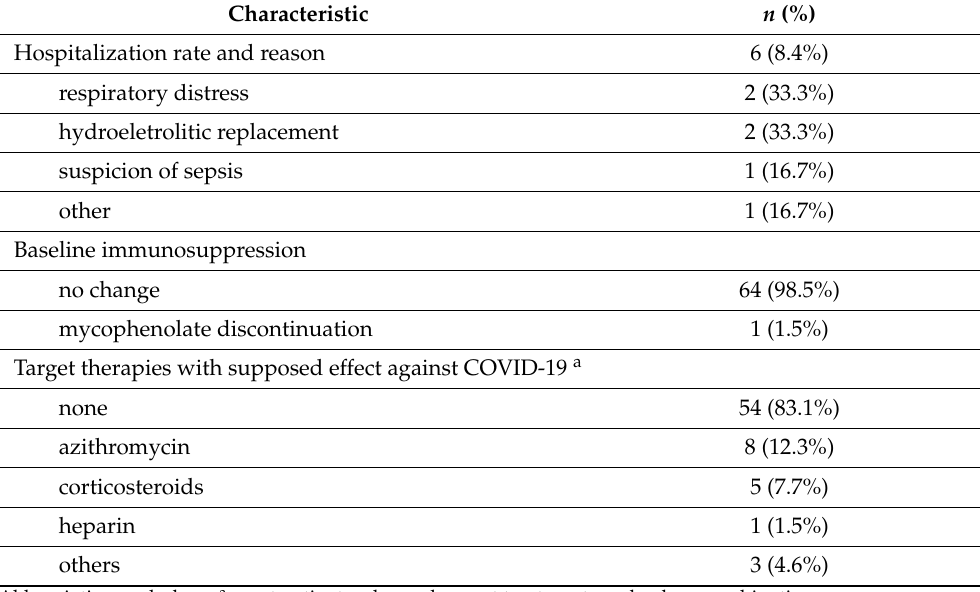
Table 3. Clinical course and outcomes of 65 outpatients PLTR with COVID-19 infection.